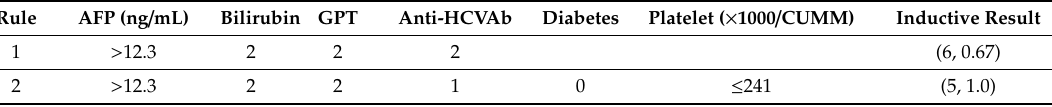
Table 10. Model 1 (no bacterial liver abscess variable) classification results—liver